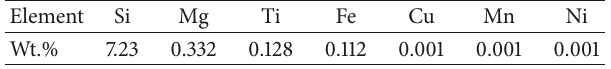
Table 1: Nominal chemical composition of A356/Wt.%.